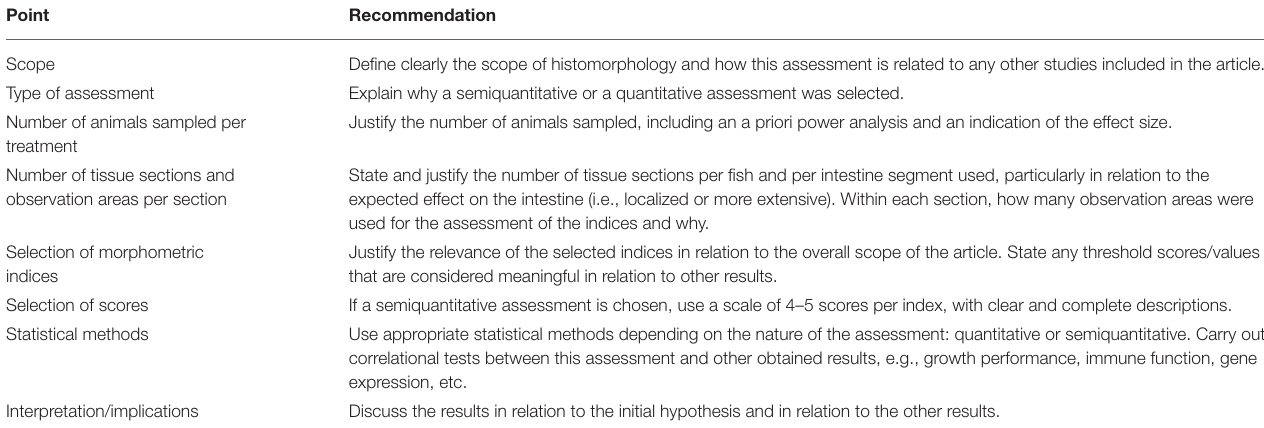
TABLE 1 | Checklist for the planning and reporting of intestine histomorphometry in fish nutrition research. Point